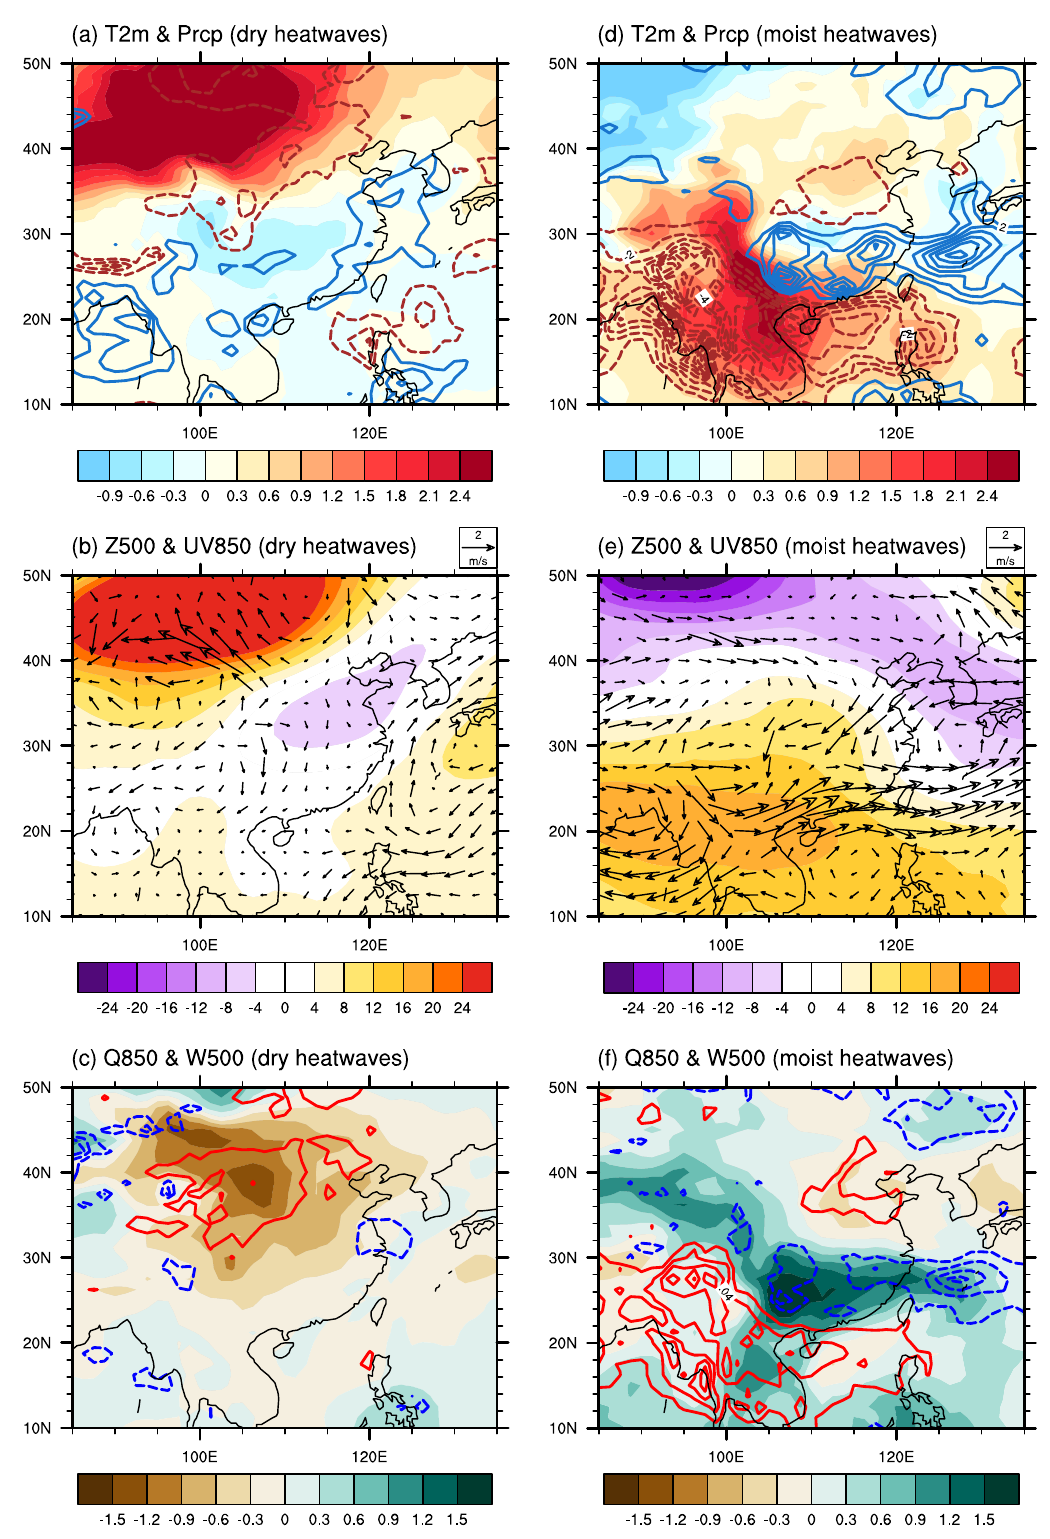
Fig. 2 Anomaly composites for heatwave days over dry/moist heatwave regions. Anomaly composites relative to long-term daily mean (climatology) of a , d 2 m air temperature (shading) [°C] and precipitation (contours) [mm day − 1 ], b , e geopotential height at 500-hPa (shading) [m] and wind at 850 hPa (vectors) [m s − 1 ], and c , f speci fi c humidity at 850 hPa (shading) [g kg − 1 ] and omega at 500 hPa (contours) [Pa s − 1 ] for a – c dry heatwave days and d – f moist heatwave days. Dry and moist heatwave days were determined as days on which the heatwaves occurred simultaneously in more than 40% of the regions where the trend was more than 0.15 days year − 1 for dry and moist heatwaves,